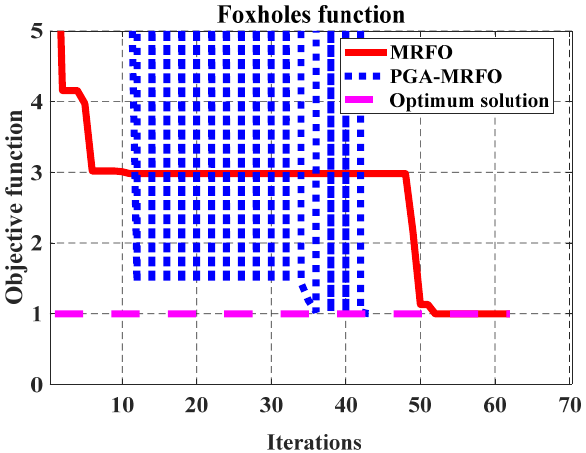
Figure 5. Converges curves for F 13 .